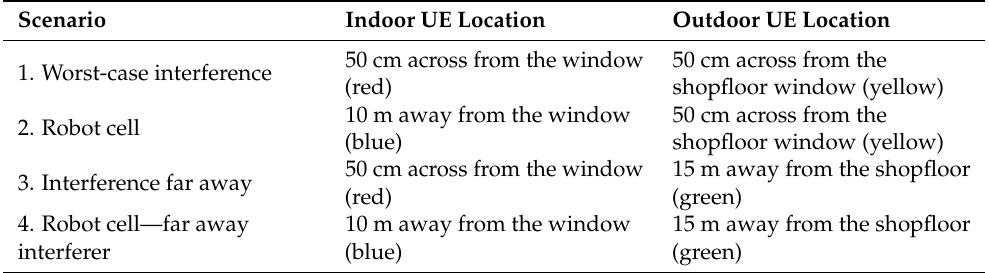
Figure 2. ( a ) Outdoor campus network deployment in Industry Campus Europe (Aachen) and location of indoor test factory, Fraunhofer IPT. ( b ) Indoor and outdoor UEs deployment location for coexistence performance evaluation around the test factory hall [2]. The figure is based on Google Maps © 2021. Table 1. Description of indoor and outdoor UE deployment locations for each of the scenarios.